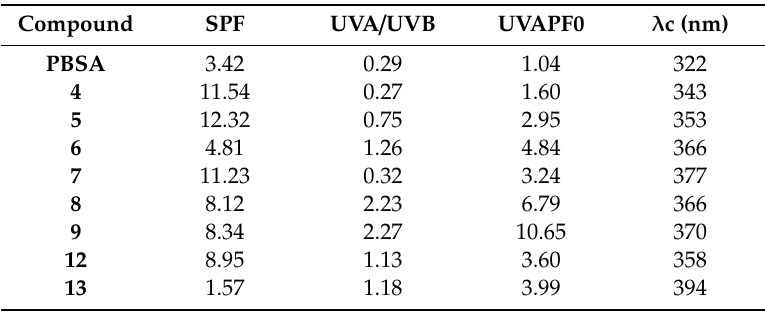
Table 2. In solution UV-filtering activity of selected hydrazones.